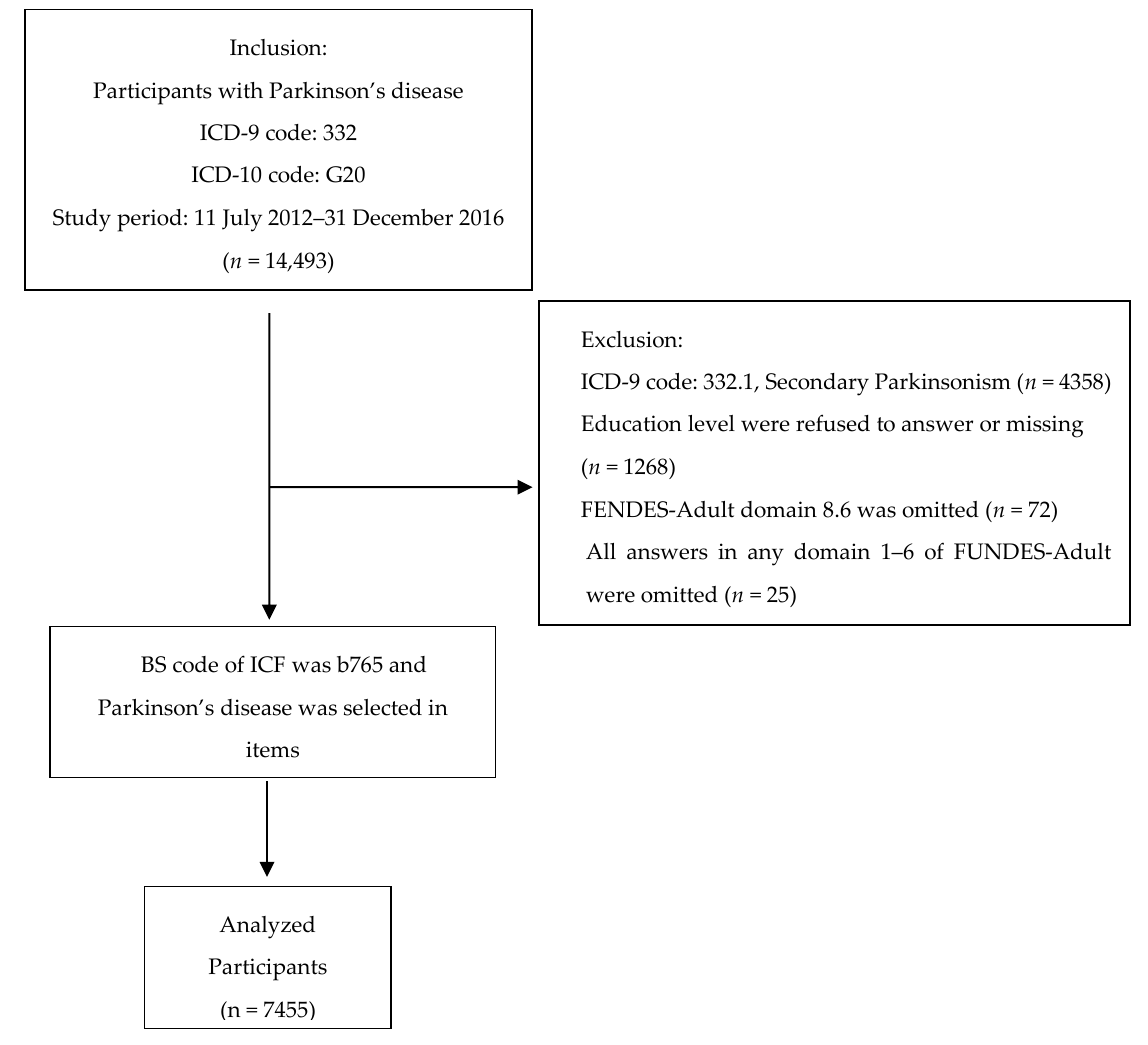
Figure 1. Sample selection flow chart.